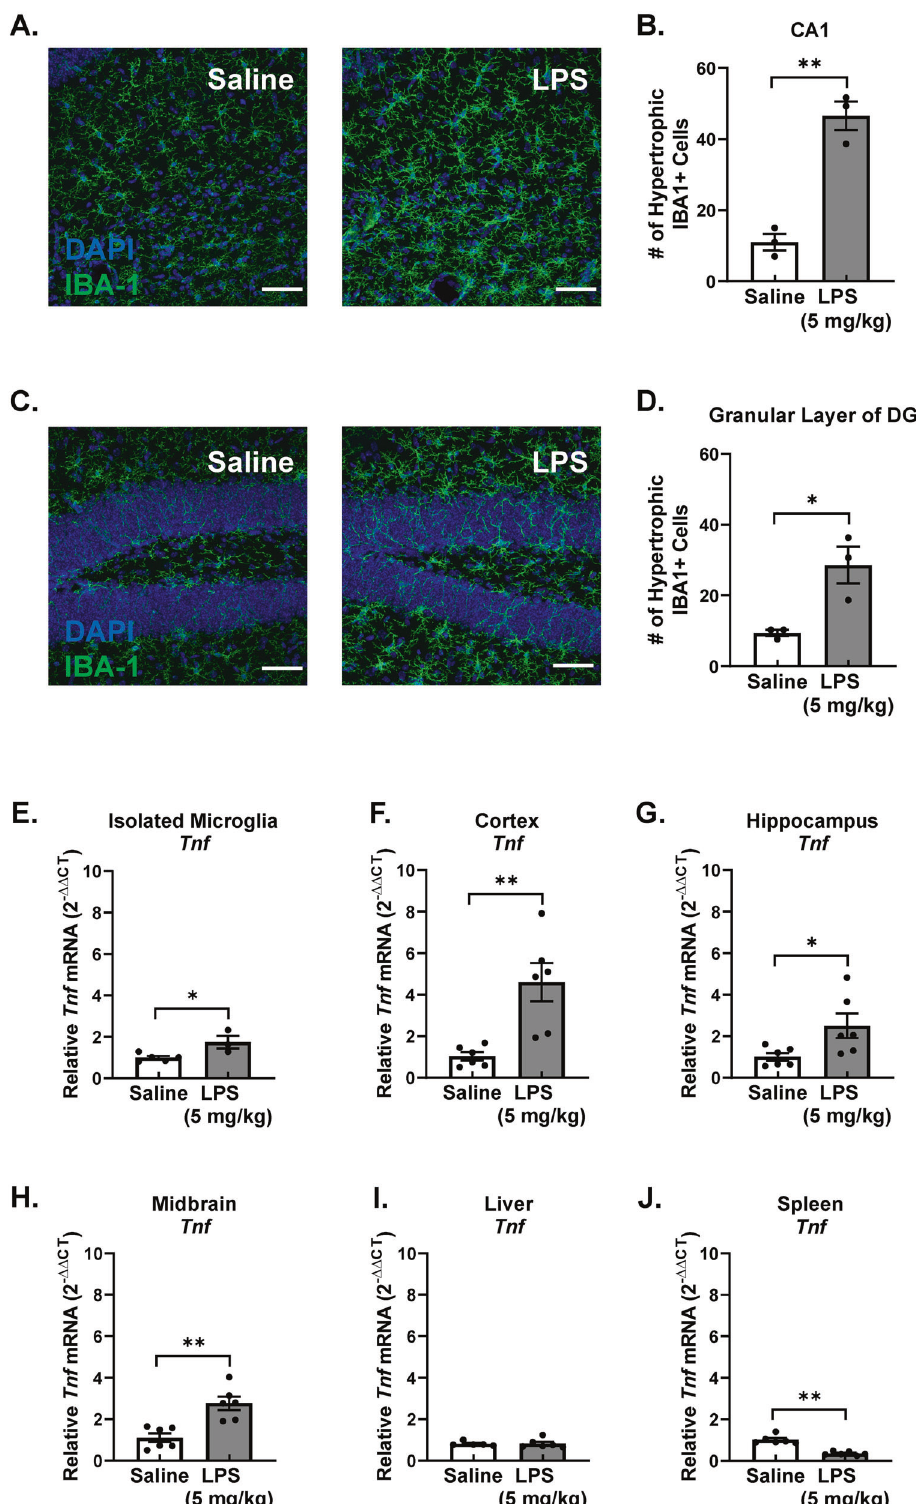
Quantitative reverse transcription polymerase chain reaction (RT-qPCR) Total RNA was extracted from brain regions, liver, and spleen tissues with TRIzol (Thermo Scienti fi c-Invitrogen, Carlsbad, CA, USA), following the manufacturer ’ s instructions. RT-qPCR was performed as previously described [57, 63]. Further details are speci fi ed in the Supplementary Information.